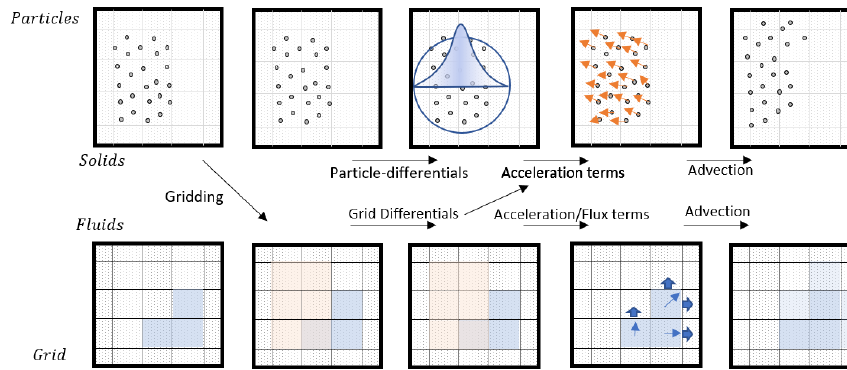
Figure C1. The sub-steps taken by the software to complete a single step of numerical integration.